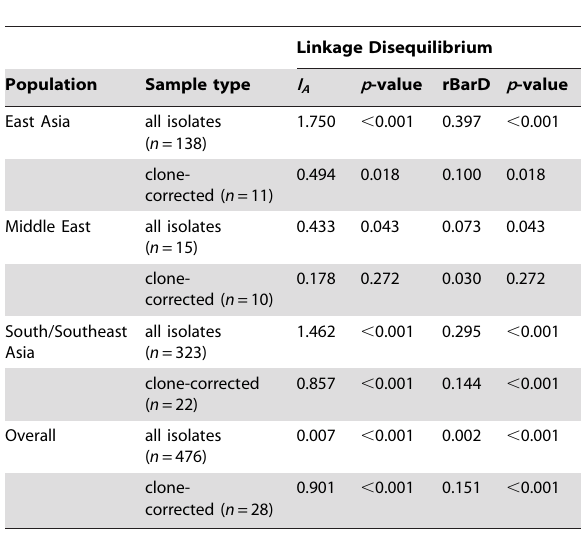
Table 7. Linkage disequilibrium analysis amongst Asian C . neoformans var. grubii populations.